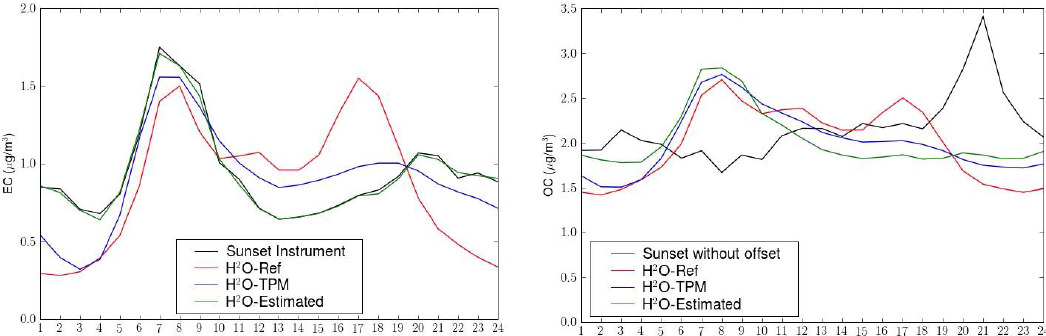
Fig. 6. Measured and modeled daily temporal profiles for EC (left) and OC (right) at the LHVP site from 5 to 25 July 2009. H 2 O-TPM stands for the results of “H 2 O-Ref” with the temporal profile of Menut et al. (2012) for traffic emissions; H 2 O-Estimated corresponds to the use of an estimated emission temporal profile that matches the observed temporal profile of EC.